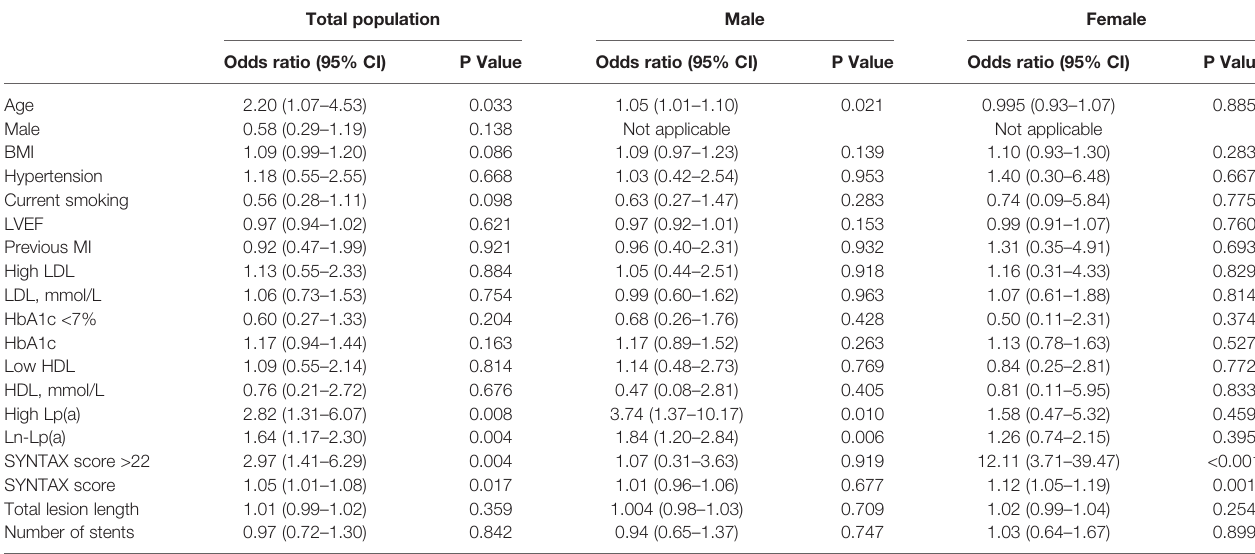
TABLE 3 | Univariate logistic regression analysis for peri-procedural myocardial infarction. Total population Male